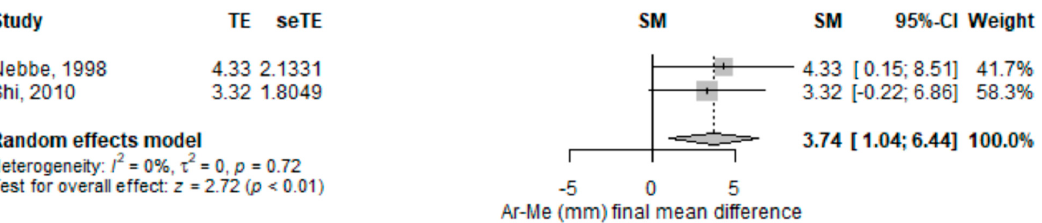
Figure 6. Forest plot for distance from articulare to menton (mm) standardized mean change differ ‐ ence. Ar ‐ Me—distance from articulare to menton; TE—effect; seTE—effect’s standard error of the effect; SM—the average discrepancy; CI—confidence interval.